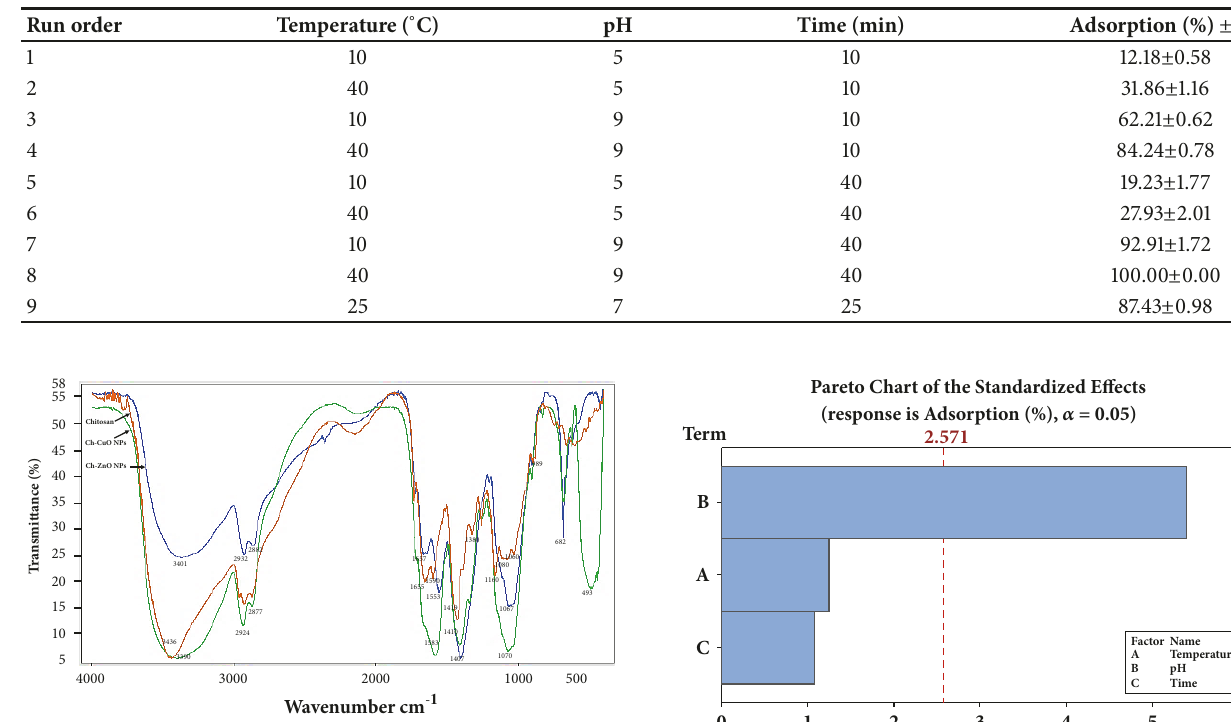
Figure 4: FT-IR spectra of chitosan (A), chitosan-copper oxide nanoparticles (Ch-CuO NPs), and chitosan-zinc oxide nanoparti- cles (Ch-ZnO NPs). Figure 5: Pareto Chart of the standardized effects of pH, tempera- ture, and time of adsorption (response is adsorption (%), 𝛼 = 0.05).